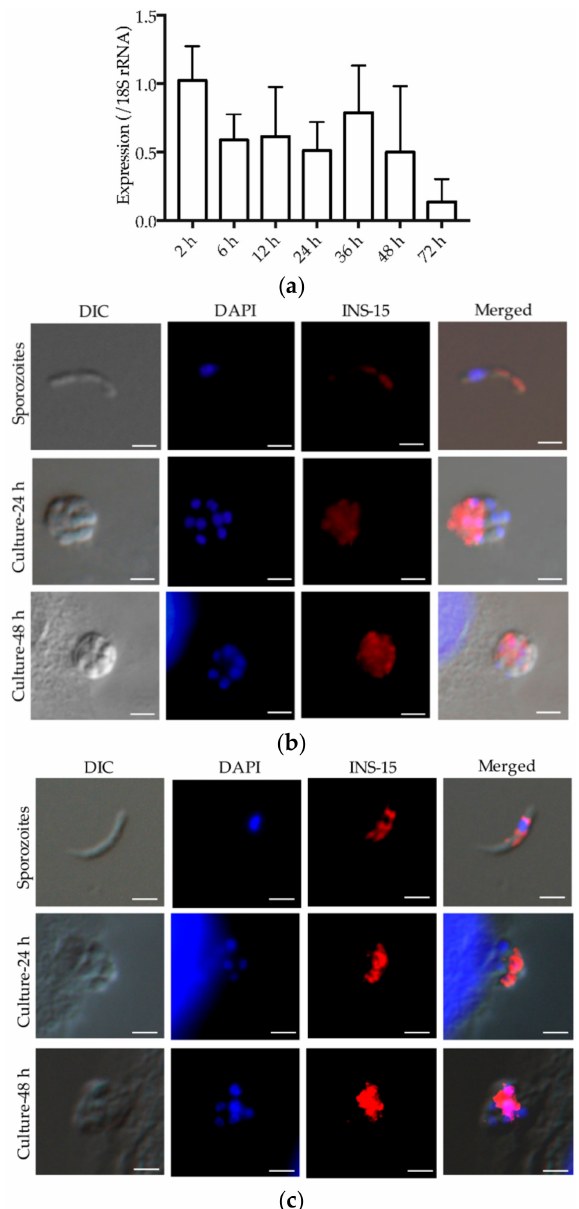
Figure 4. Expression of the INS-15 gene and protein in C. parvum . ( a ) Relative expression level of the cgd3_4260 gene at various C. parvum cultivation time as determined by reverse transcription-qPCR. Data from the Cryptosporidium 18S rRNA gene were used in data normalization. Data presented are mean ± SD from three replicate assays, with qPCR analysis of each RNA extraction being performed in duplicate. ( b , c ) Expression of INS-15 protein in C. parvum life cycle stages indicated by immunofluorescence microscopy with anti-INS-15 domain I antibodies ( b ) or anti-INS-15-specific polypeptide antibodies c ). Sporozoites of C. parvum (top panel) used were obtained from excysted oocysts, while intracellular developmental stages were obtained by cultivating C. parvum in HCT-8 cells for 24 h (middle panel) and 48 h (bottom panel). The images were taken under di ff erential interference contrast (DIC), with nuclei being counter-stained with 4 (cid:48) , 6-diamidino-2-phenylindole (DAPI), parasites stained by immunofluorescence with anti-INS-15 antibodies, and superimposition of the three (Merged). Scale-bars: 2 µ